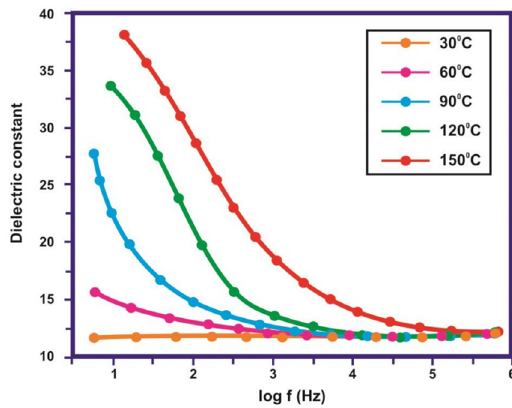
O nanoparticles Figure 6. Dielectric constant plot for NiFe 2 4 Figure 7 shows the curve explaining how the dielectric loss factor varies with the frequency at various temperatures. It becomes clear from the graph that the dielectric loss decreases with the increase in frequency and attains a low value in the high frequency region. The study clearly showed that the dielectric loss suddenly dropped at lower frequencies and attained constancy at higher frequencies. Further, it could be observed that owing to the space charge polarization the dielectric loss decreased with the increase in the frequency for all temperatures 24,25 .